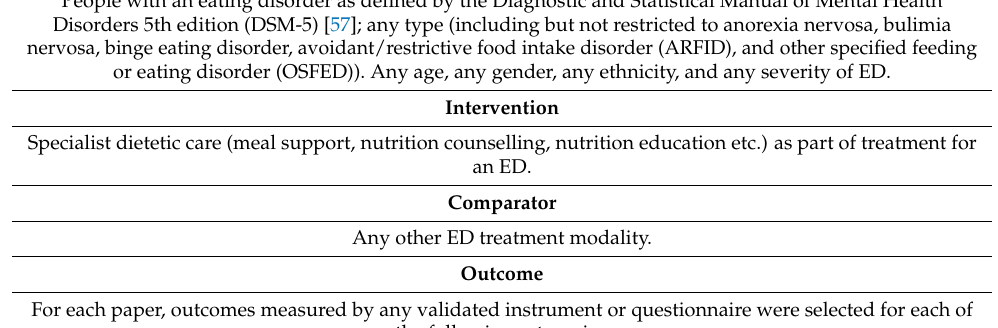
Table A2. PICO criteria.